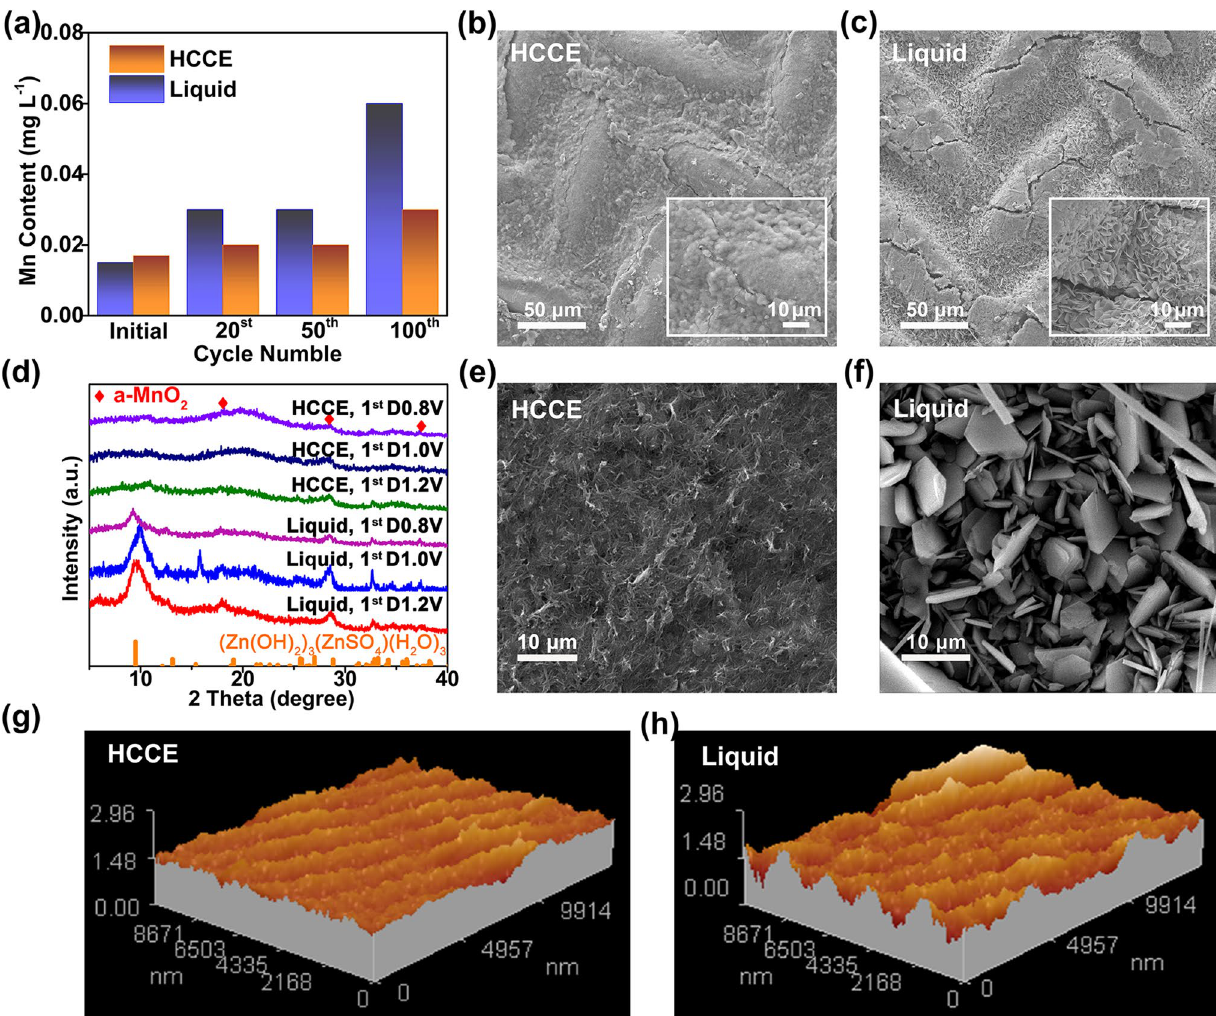
Fig. 3 a Element analysis of dissolved Mn 2+ in Zn/MnO 2 battery during cycling with 2 M ZnSO 4 aqueous electrolyte and colloidal electrolyte (2 M ZnSO 4 + palygorskite). SEM images of b cathode of the battery with HCCE and c the battery with liquid electrolyte after initial fully discharge to 1.0 V at 200 mA g −1 . d ex-situ XRD patterns of the cell with HCCE and liquid electrolyte discharged/charged to different volt- age states at 200 mA g −1 . SEM images of e anode of the battery with HCCE and f the battery with liquid electrolyte cycled for 200 cycles 1000 mA g −1 . AFM images of g anode of the battery with HCCE and h the battery with liquid electrolyte cycled for 200 cycles 1000 mA g